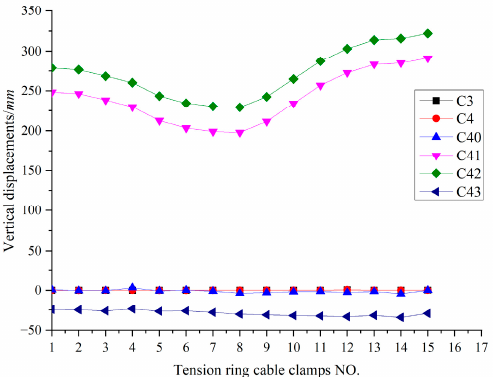
Figure 49. Vertical deformation Uz curve of typical nodes of tension ring (mm).